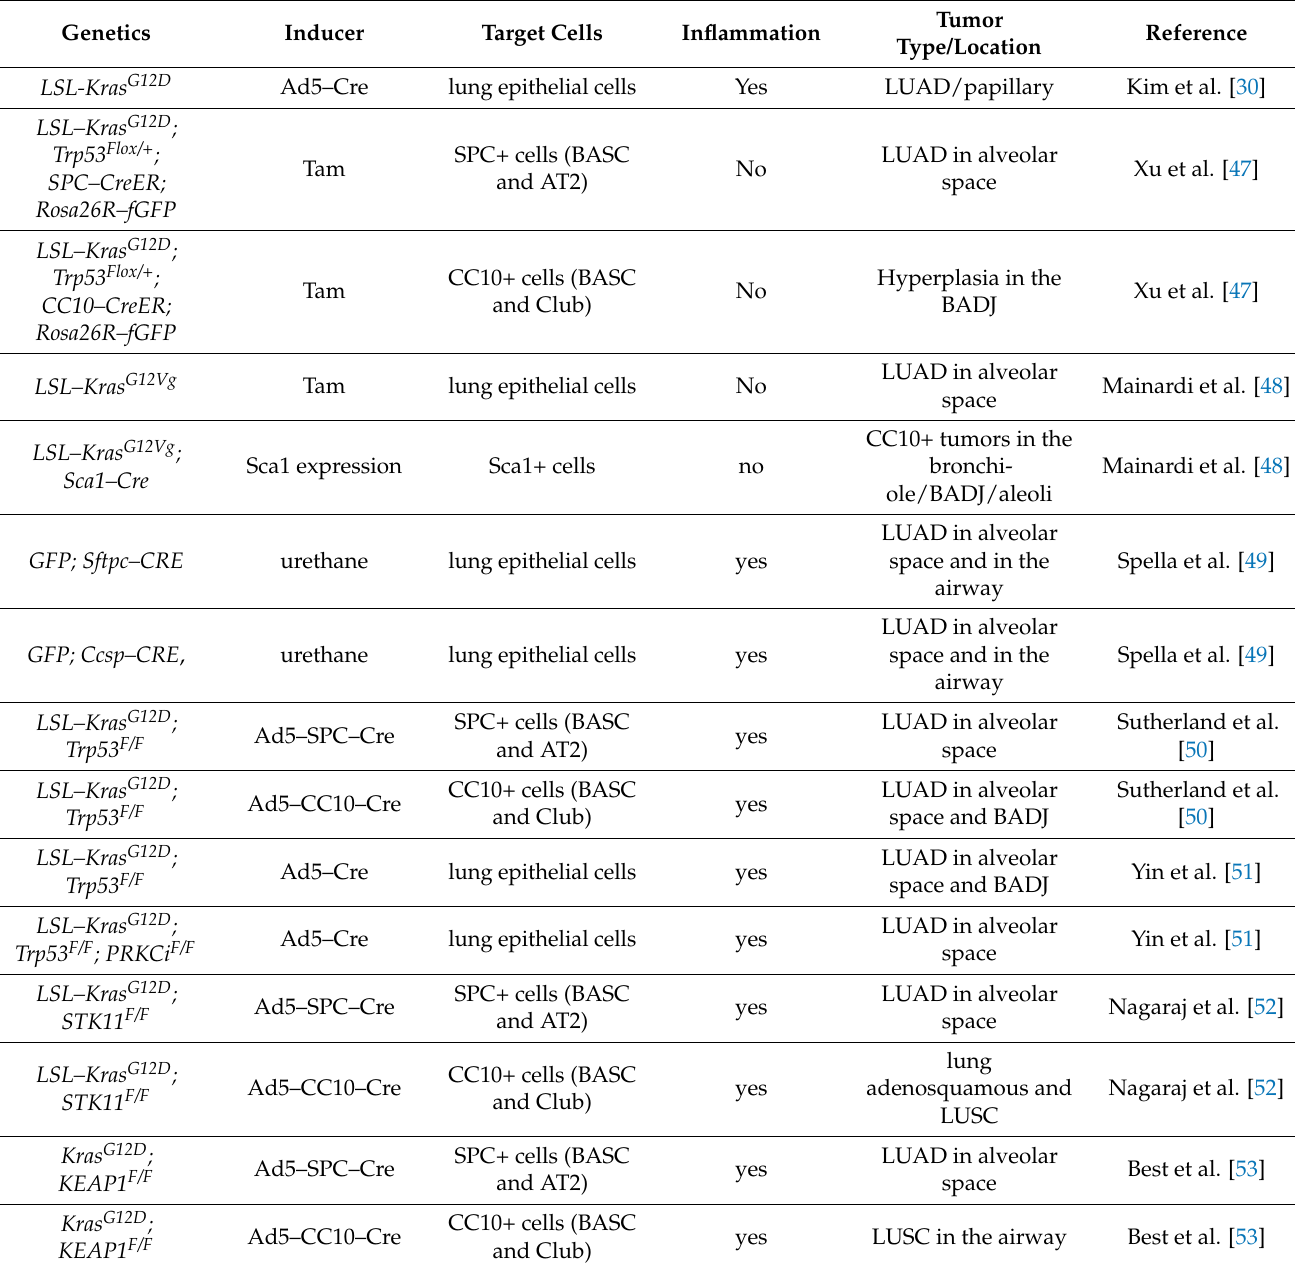
Table 1. Summary of LUAD mouse model to distinct cells of